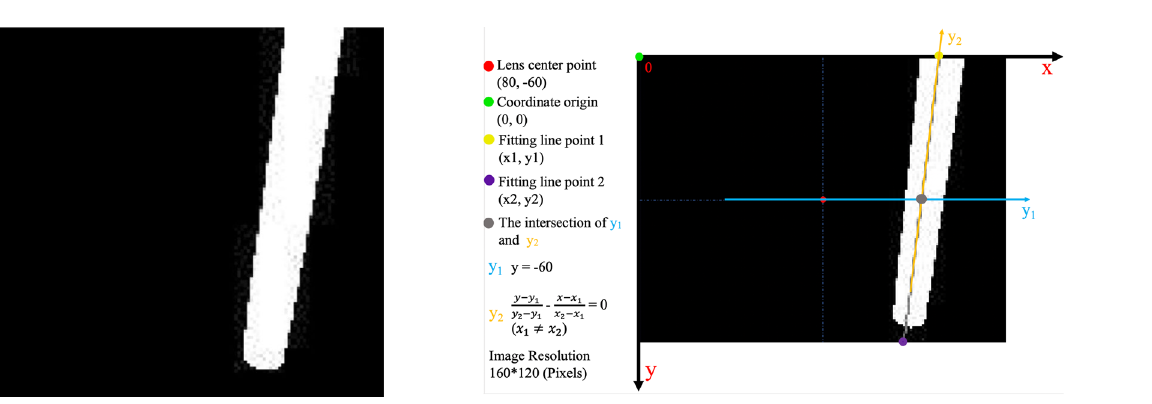
Fig. 12 A schematic illustration of a coordinate system